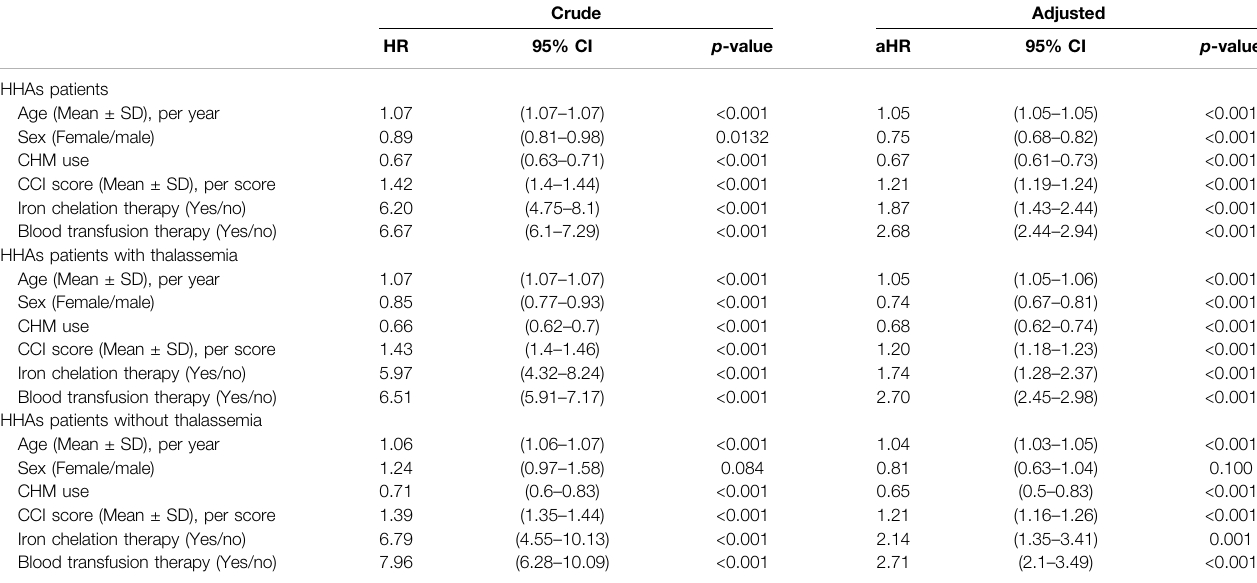
TABLE 2 | Risk of overall mortality in patients with hereditary hemolytic anemias (HHAs) in Taiwan.